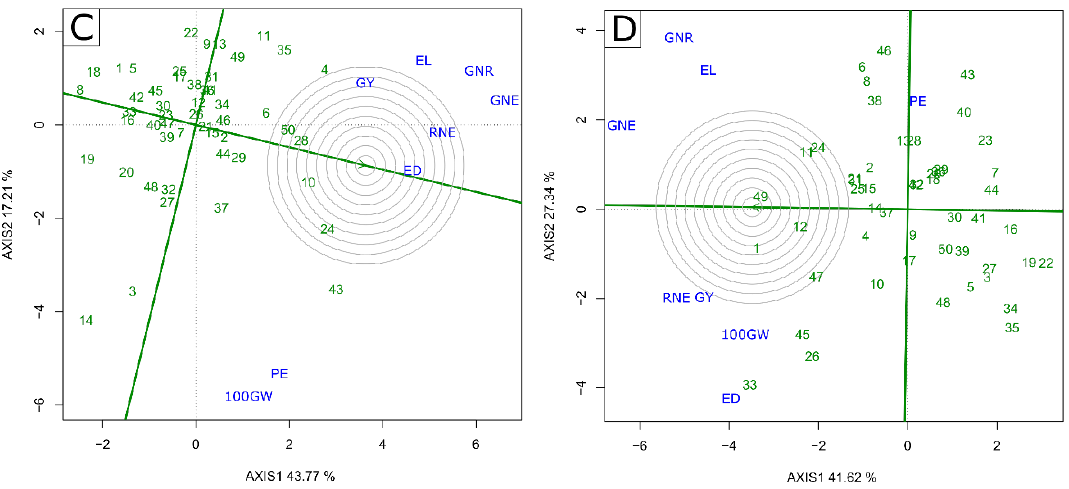
Figure 5. Biplot “Ranking Genotypes” graph for ( A – C ) water stressed (WS) and ( B – D ) well-watered (WW) conditions, in crop seasons 2020 ( A , B ) and 2021 ( C , D ). GY — grain yield; PE — Popping expansion; GNE — grain number per ear; 100 GW — 100-grain weight; RNE — Row number per ear; GNR — Grain number per row; ED — Ear diameter; EL — Ear length; (-) signal indicating negative values.